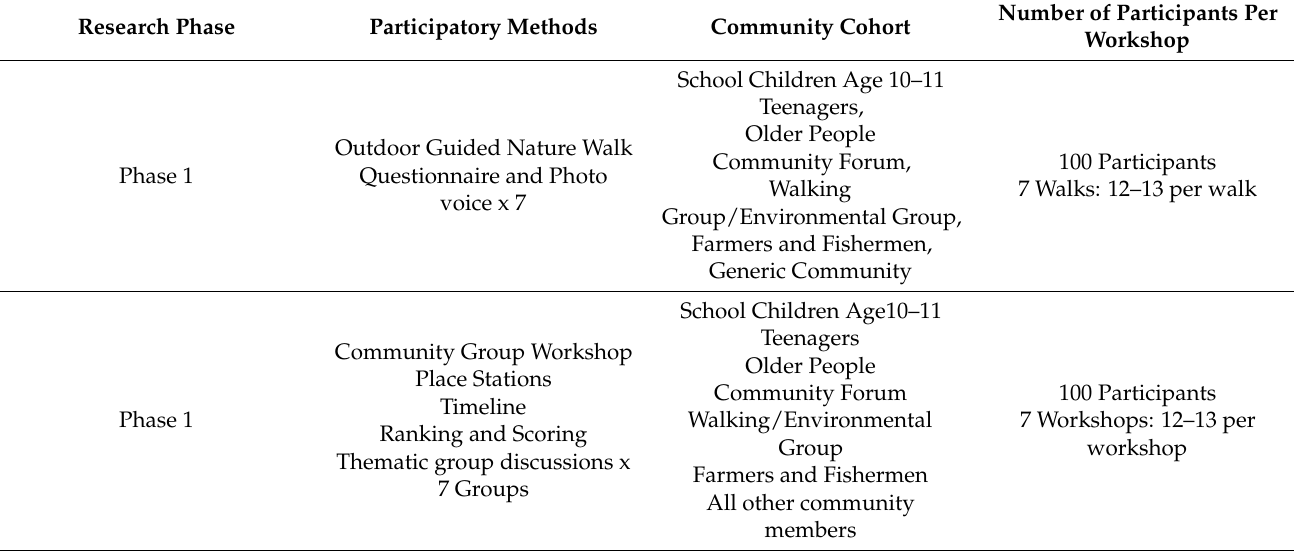
Table 1. Participatory Methods to be Employed Across the Research